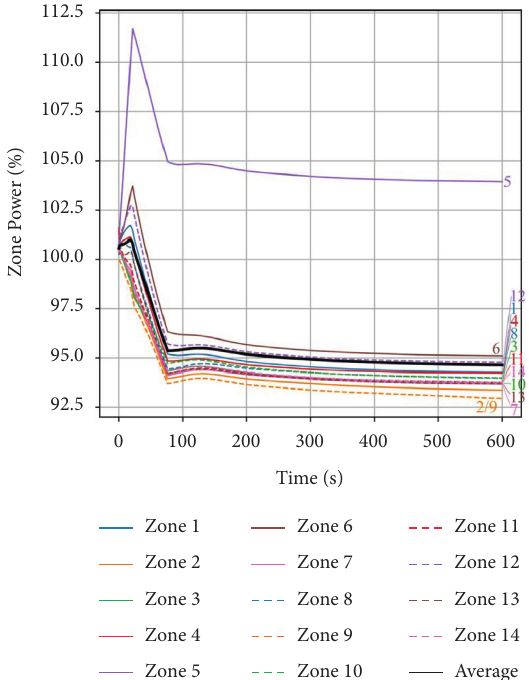
Figure 18: Zone powers for zone control failure